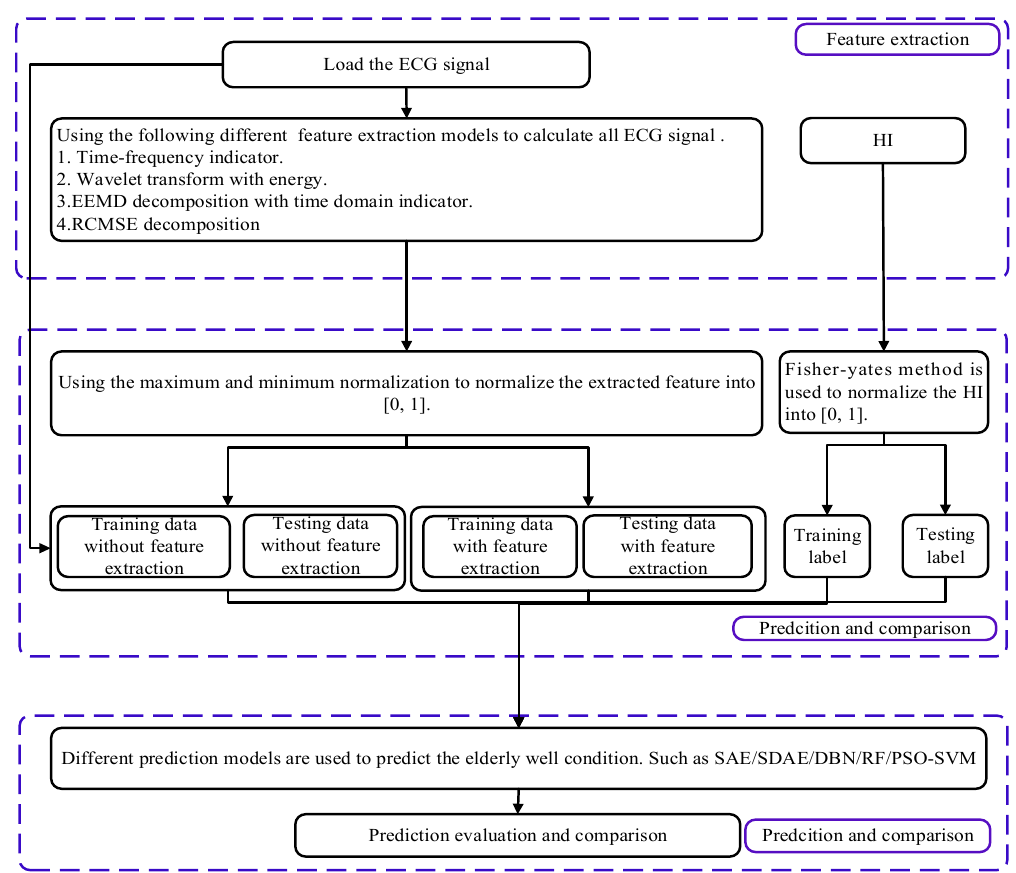
Figure 1. The flowchart of the developed approach (HI: health index).